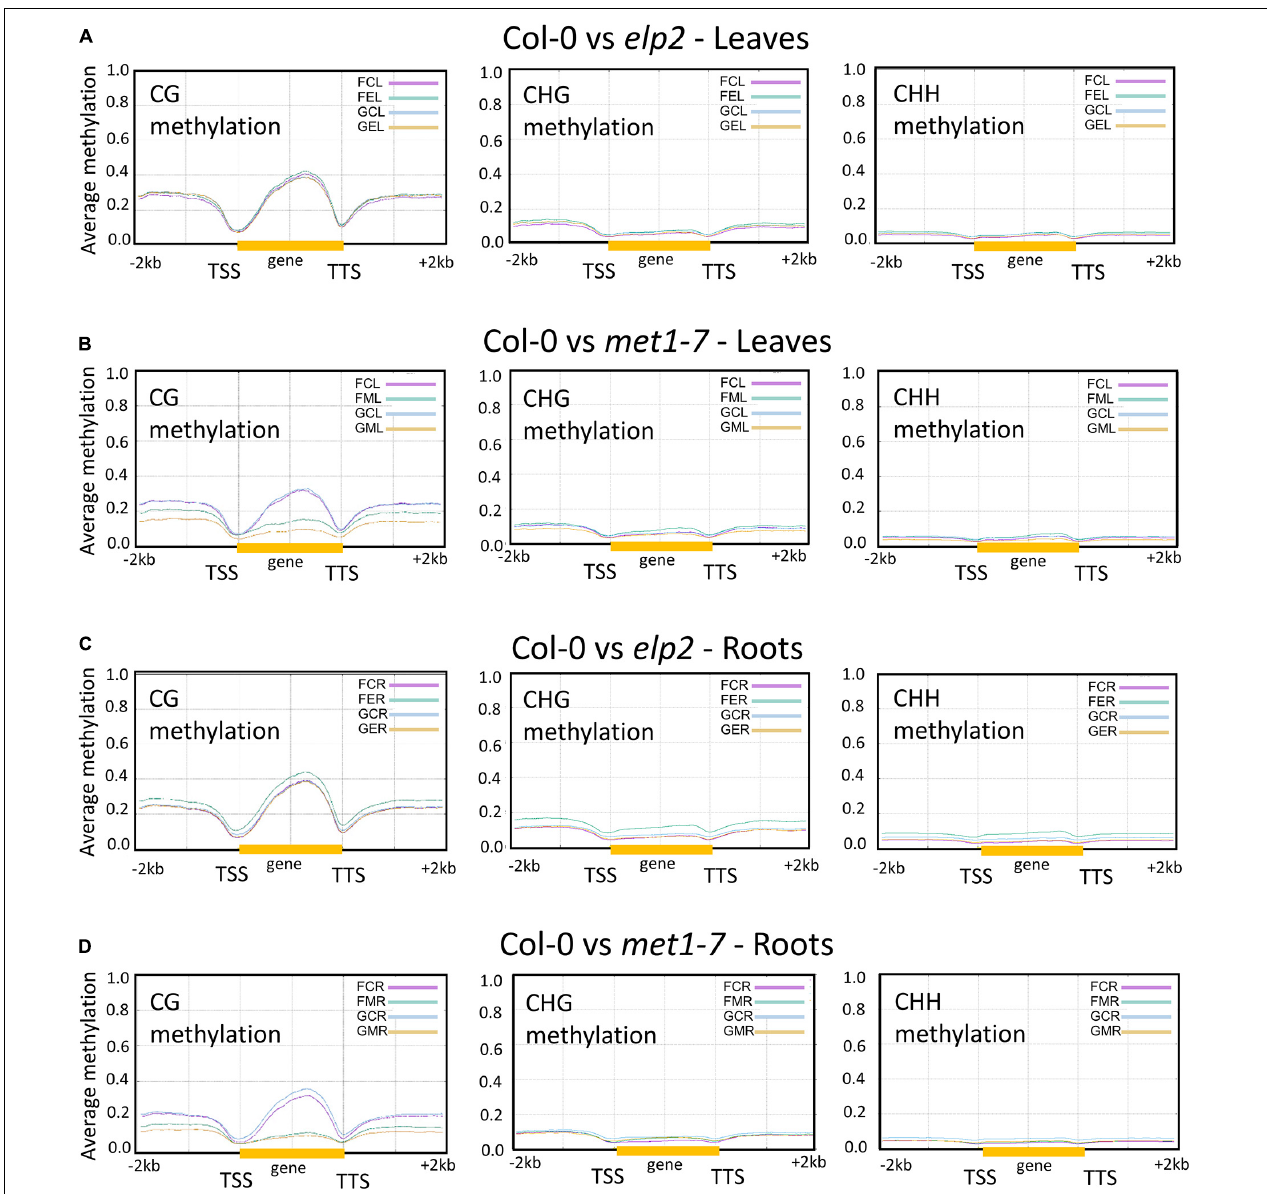
FIGURE 3 | Pairwise comparison of the average methylation levels across protein-coding genes between the genotypes in CG, CHG, and CHH contexts. Gene bodies from transcription start site (TSS) to transcription termination site (TTS; highlighted by the yellow bar) as well as the flanking upstream 2 kb and downstream 2 kb are shown. Each pairwise comparison between genotypes and environment is denoted by a three-letter code. The first letter denotes the environment [flight, (F) and ground (G)], the second letter denotes the genotype [Col-0 (C), elp2-5 (E), and met1-7 (M)], and the third letter denotes the specific tissue [leaves (L) and roots (R)]. The y axes indicate the average methylation levels in each of the CG, CHG, and CHH contexts. A pairwise comparison between the various genotypes are depicted here Col-0 vs elp2-5 leaves (A) and roots (C) , along with Col-0 vs met1-7 leaves (B) and roots (D)